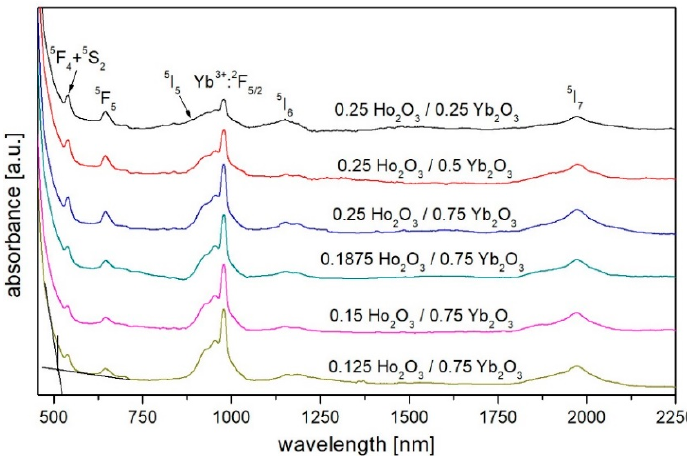
Figure 4. The absorbance spectrum of bismuth-germanate glasses co-doped with holmium and ytterbium ions.